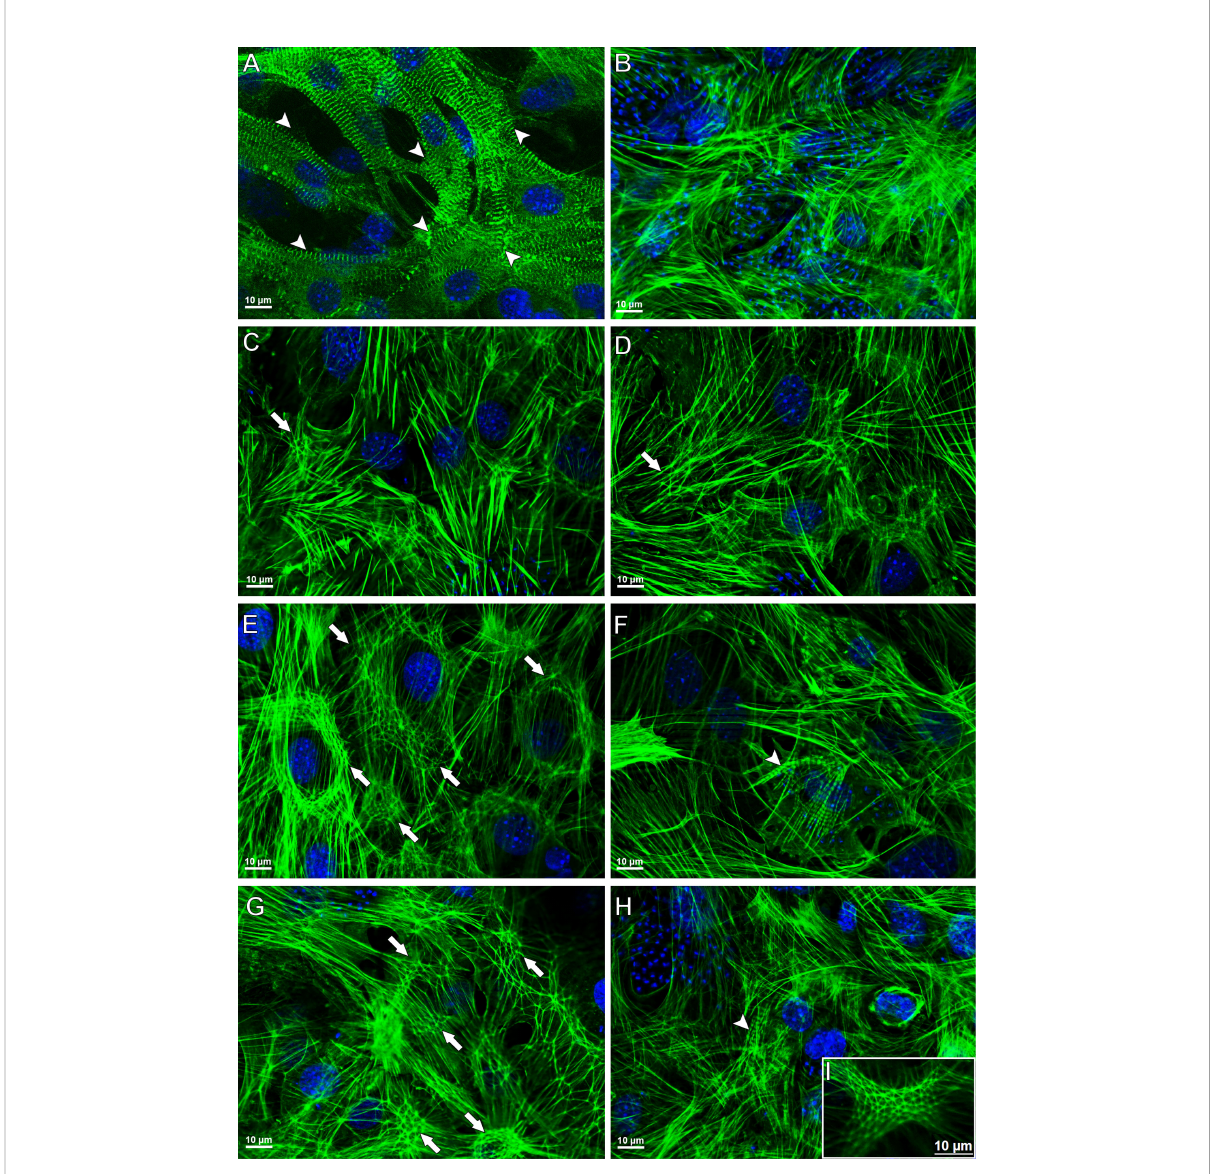
FIGURE 10 Cytoskeletal remodeling in T. cruzi -infected HCs treated for 72 h with Bz, AMD or their combination, demonstrating the predominance of the phenotype generated by Bz in the combination Bz + AMD. Actin fi laments and DNA were detected by phalloidin – FITC and DAPI, respectively. (A) Myo fi brils in uninfected cells (NI); (B) Myo fi bril disruption in untreated infected cells ( Tc ); (C, D) AMD MT (IC 50 /72 h = 2.5 m M); (E, F) Bz MT (IC 50 / 72 h = 5.4 m M); (G – I) Bz:AMD Comb (Bz: IC 50 /72 h = 1.3 m M; AMD: IC 50 /72 h = 2.5 m M). Of note, the rearrangement of actin structure in HCs is related to the reduction in intracellular parasite infection. Arrow heads indicate myo fi brils; arrows indicate an actin polygonal con fi guration, and a thin arrow indicates an actin belt around the cell